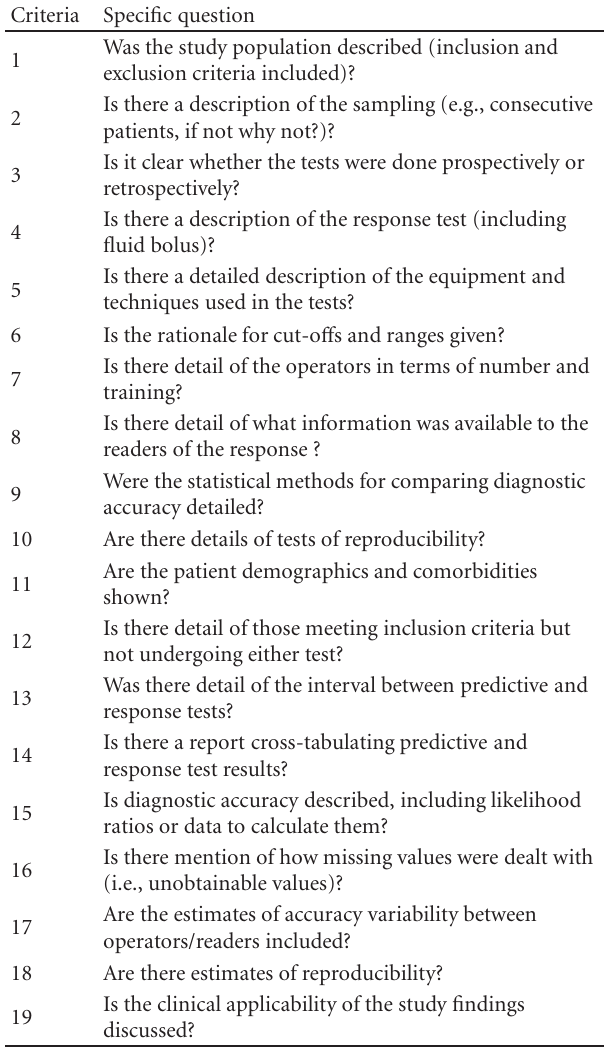
Table 1: Modified STARD criteria assessment [10]. Criteria Specific